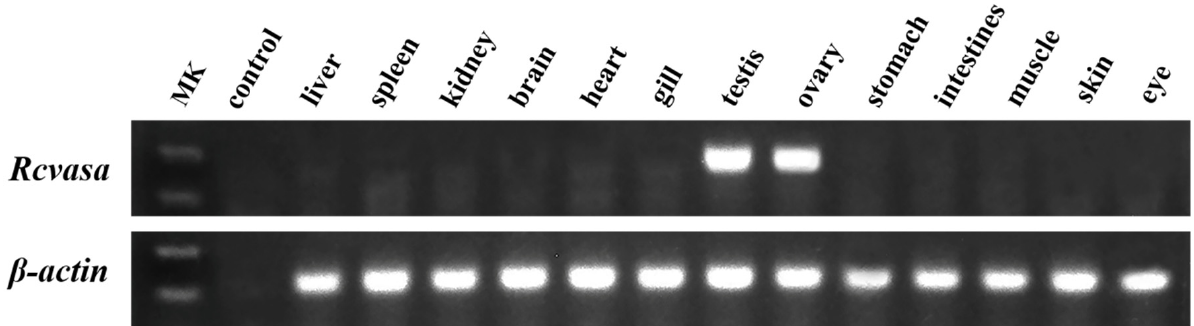
Figure 3. Rcvasa mRNA expression in various tissues of cobia. cDNA from various tissues (liver, spleen, kidney, brain, heart, gill, testis, ovary, stomach, intestines, muscle, skin, and eye) was used. β -actin was used as an internal control. MK: DNA marker; control: negative control without cDNA template.